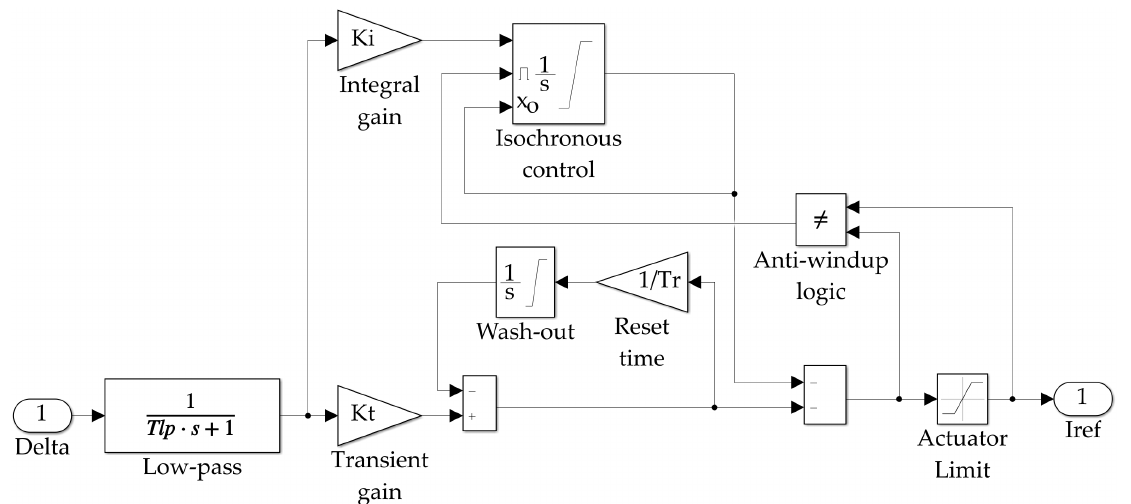
Figure 3. Block diagram of the proposed controller considering non-linear